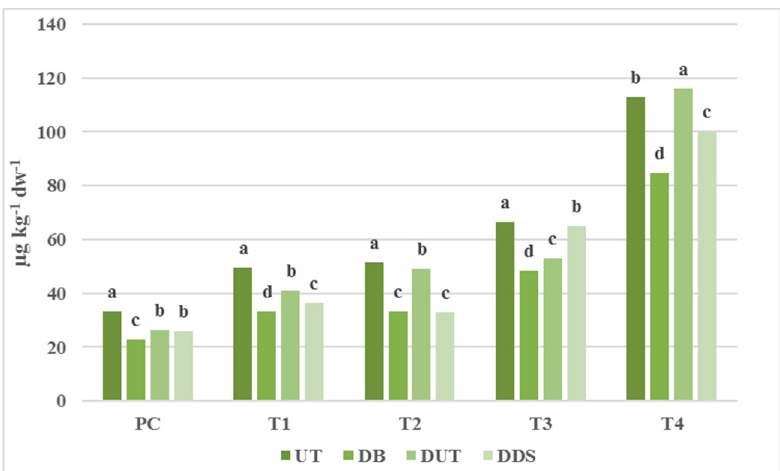
Figure 4. Selenium content of fresh and pre-treated dried olive samples. Lowercase letters show differences by Tukey's post hoc test. PC: Plant Control olives); T1–T4: olives obtained by plant treated with Se once (T1), twice (T2), thrice (T3) and four times (T4); UT: olives not dried; DB: olives treated with brine and then dried; DUT: dried olives without any drying pre-treatment; DDS: olives treated with dry salt and then dried.